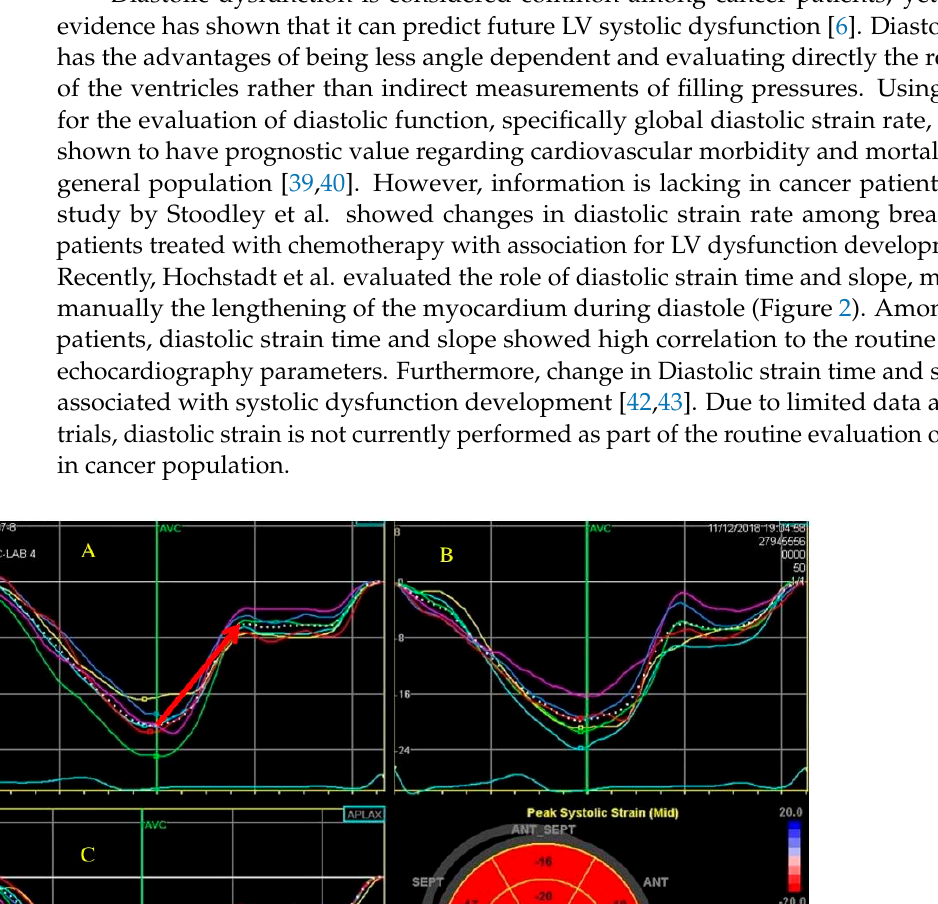
The left atrium (LA) plays an important role in the regulation of filling pressure and LV diastolic function. The LA functions as a reservoir to blood returning from the pulmo- nary veins, as a conduit to blood flowing during early diastole to the LV and as a pump contracting in late diastole (Figure 3). Left atrial strain (LAS) provide a more accurate evaluation of the diastolic function, compared to the routine echocardiographic parame- ters [44], as determined by invasive measurement (wedge pressure) [45]. LAS evaluation is considered more feasible as it can be calculated from a single apical four-chamber view and is independent to mitral valve pathology. Decreased LAS, with LAS reservoir (LASr) specifically, was found useful in predicting cardiovascular outcomes in healthy and heart failure populations [46,47]. LASr value below 35% is considered as diastolic dysfunction [48]. A recent study conducted on pediatric patients after ANT therapy found a significant decrease in LAS [49]. In contrast, Santoro et al. did not find significant changes in LAS among adult patients during ANT exposure [50]. Furthermore, to date there is no data regarding the predictive value of relative change in LAS on cardiac outcomes.